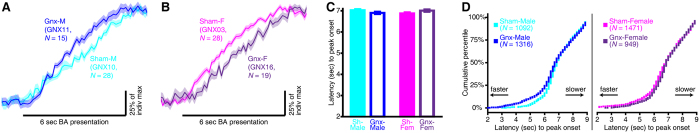
Odorant-evoked spH signals are accelerated by gonadectomy in males, but slowed by gonadectomy in females.(A,B) BA-evoked spH signals compared between representative Sham-male (GNX11) and Gnx-male (GNX10) subjects (A) and also between representative Sham-female (GNX03) and Gnx-female (GNX16) subjects (B). The solid lines ± shaded regions represent the mean ± SEM fluorescent record across all BA-evoked glomerular responses per subject, and the Ns indicate the number of glomeruli that are contributing to each subject’s mean BA-evoked spH signal. (C) Mean ± SEM latency to onset of peak spH signal from sex × surgical treatment groups. (D) Cumulative probability plots showing the distributions of peak latency values pooled across individual fluorescent records. The Ns indicate the number of odorant-evoked spH signals pooled across odorants.